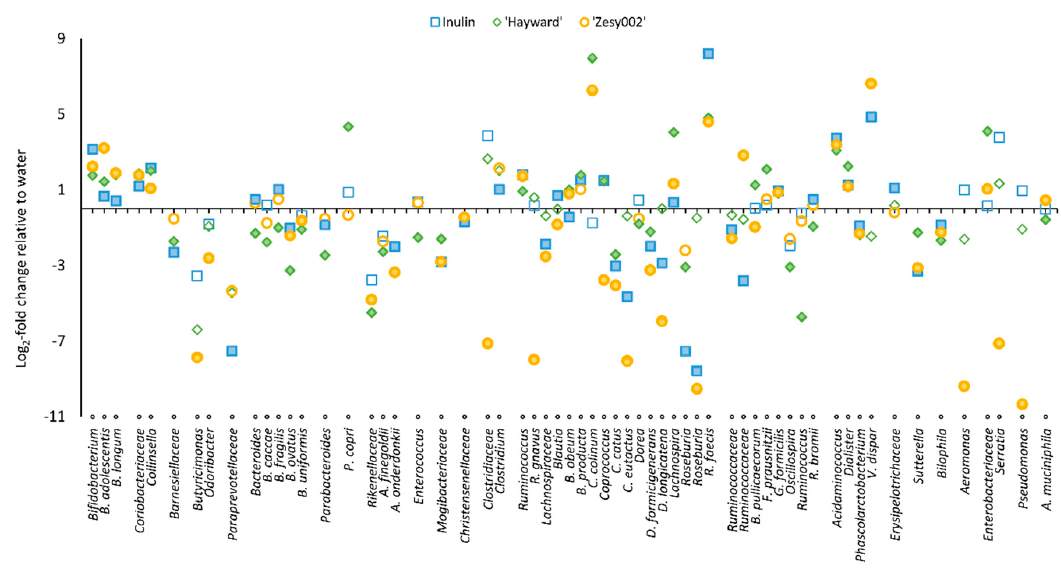
Figure 3. Changes in microbial abundances in the 18 h fermenta of ‘Hayward’, ‘Zesy002’ and inulin at the genus/family level in comparison with the water control. The filled data points indicate significance ( p < 0.001) in comparison to the water control.